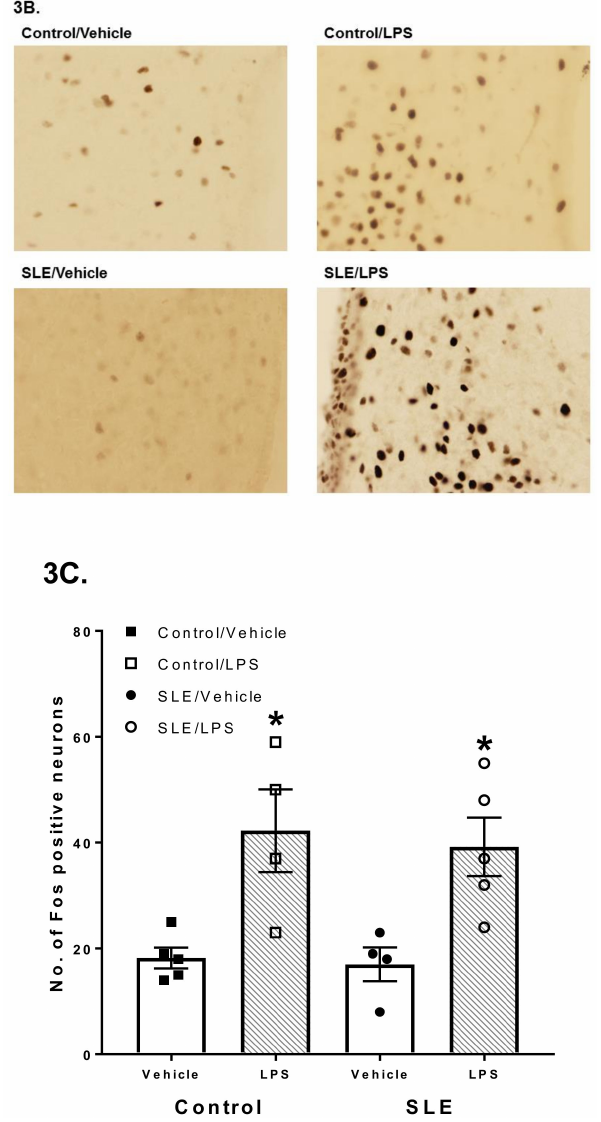
Figure 3. ( A ) Examples of c-Fos and corticotropin-releasing factor (CRF) staining in the paraventricular nucleus (PVN) parvocellularis. As vasopressin-secreting neurons also comprise the parvocellular region of the PVN, CRF staining was used to verify the presence and activation of CRF-secreting parvocellular neurons in the PVN. ( B ) Representative images of the paraventricular nucleus taken at 40 × from systemic lupus erythematosus (SLE) and control mice. ( C ) Quantitative representation of positive cell counts between lipopolysaccharide (LPS)-treated SLE and control mice. All values are reported as mean ± SEM, and the results of the two-way ANOVA indicated significant differences between LPS-challenged SLE and control mice compared to their vehicle-treated counterparts. * p SLE/LPS vs. SLE/Vehicle and p Control/LPS vs.